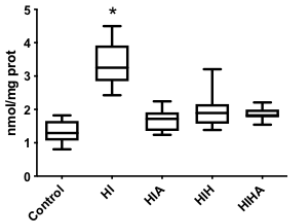
Figure 4. Box plot plasma carbonyl groups. C: Control, HI: Hypoxia-ischemia, HIA: Hypoxia-ischemia + allopurinol, HIH: Hypoxia-ischemia + hypothermia, HIHA: Hypoxia-ischemia + hypothermia + allopurinol. * p < 0.05 in post-hoc analysis compared to HI.